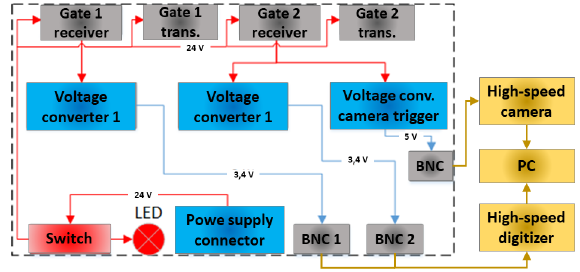
Figure 7. Block scheme of laser sensor and camera trigger